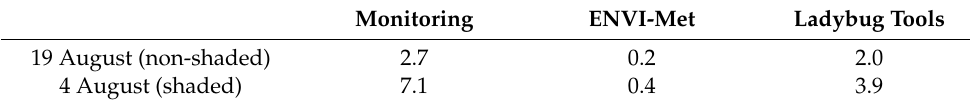
Table 6. Mean thermal gap per hour for the monitoring and simulation